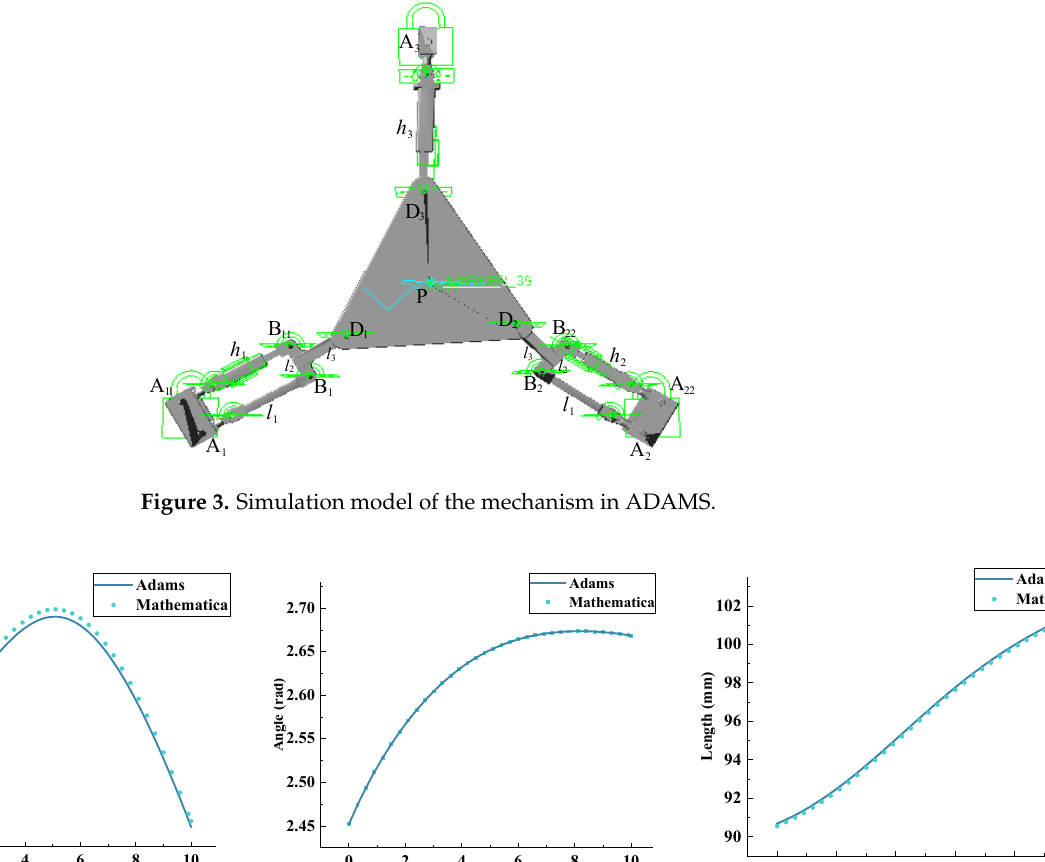
Figure 4. Comparisons of inverse kinematics theory and simulation results: ( a ) ϕ ; ( b ) φ ; ( c ) 3 h .